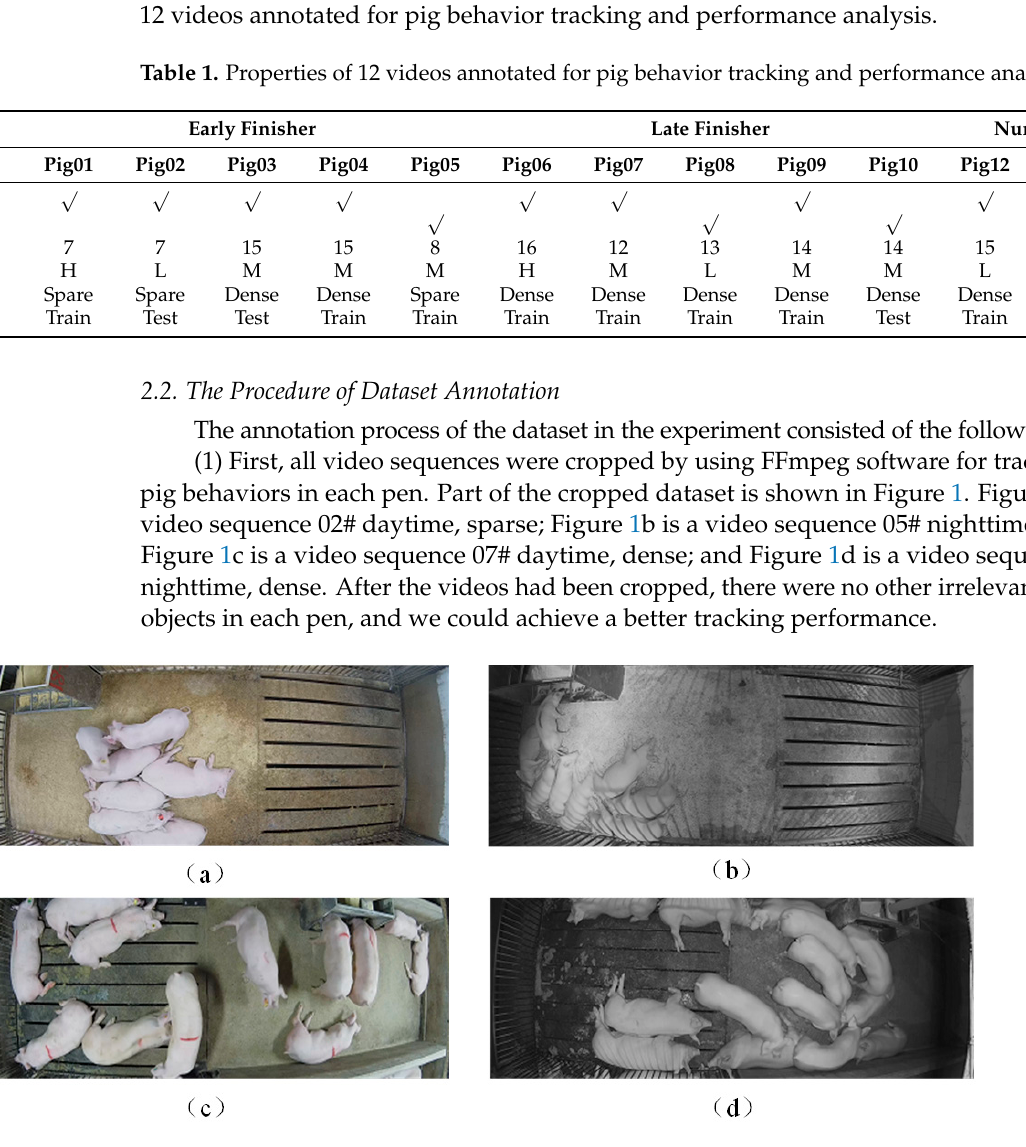
Table 1. Properties of 12 videos annotated for pig behavior tracking and performance analysis.